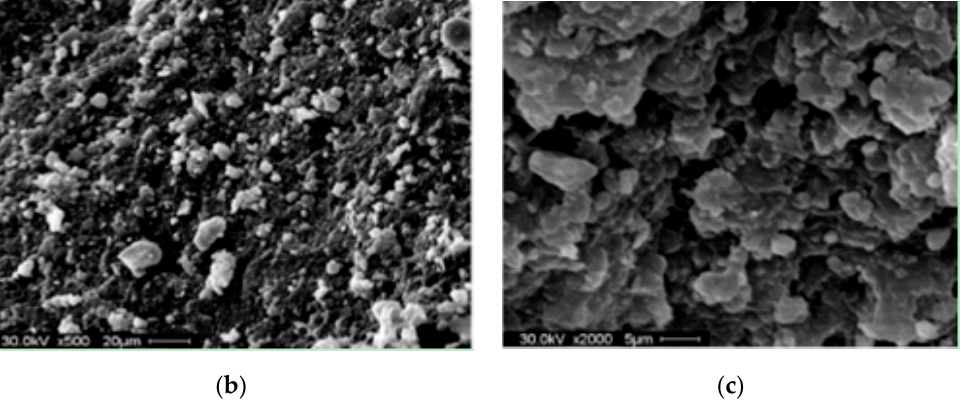
Figure 1. Electron micrographs of surfaces of rubber crumbs: ( a ) magnification level at 100×; ( b ) magnification level at 500×; and ( c ) magnification level at 2000×.